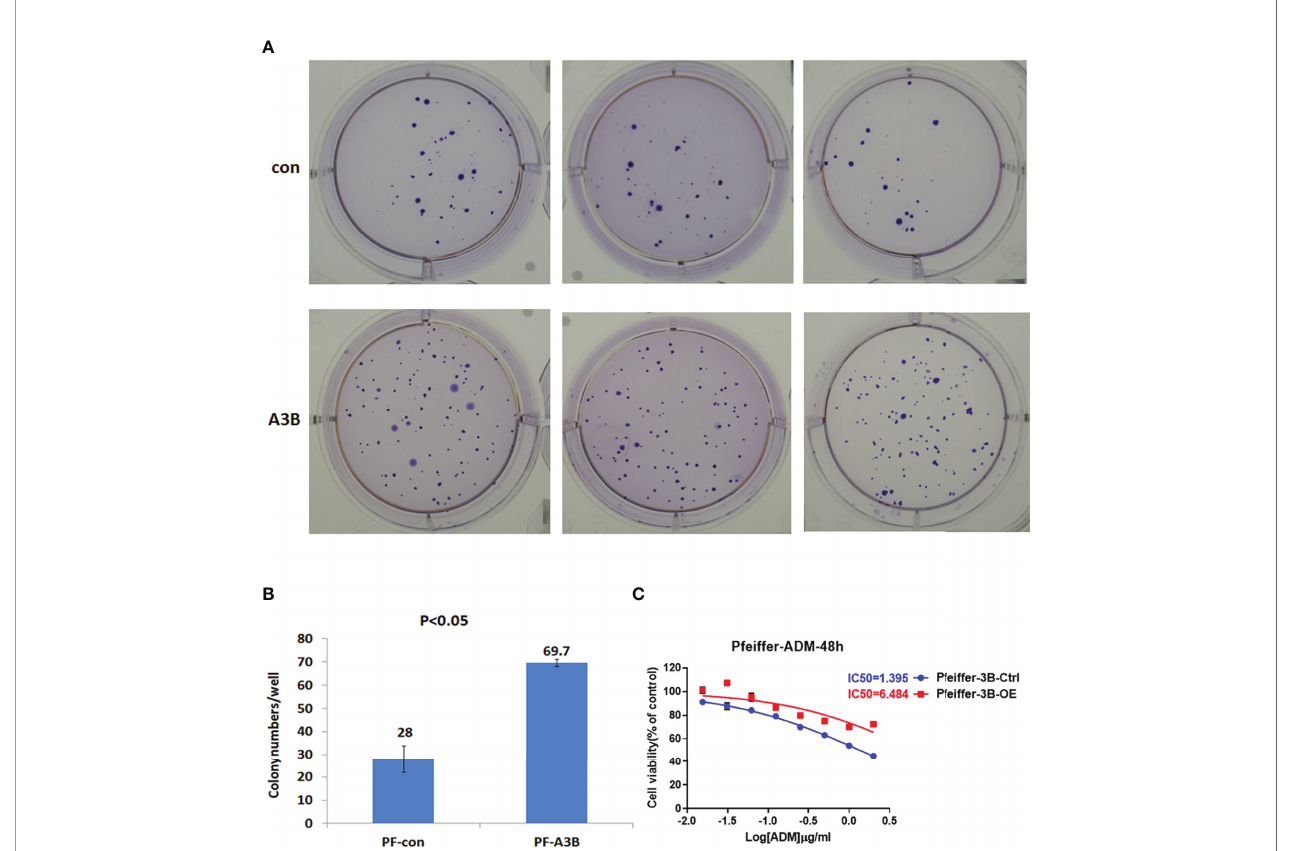
FIGURE 7 | APOBEC3B-induced proliferation and drug resistance in DLBCL cells. (A, B) Colony formation after induction of APOBEC3B expression. A3B inducible, APOBEC3B-Flag/pLV-Ptight-puro vector-transfected Pfeiffer cells; Con, pLV-Ptight-puro vector-transfected Pfeiffer cells; PF-A3B, APOBEC3B-Flag/pLV-Ptight-puro vector-transfected Pfeiffer cells; PF-con, pLV-Ptight-puro vector-transfected Pfeiffer cells. (C) Doxorubicin resistance after induction of APOBEC3B expression. ADM, doxorubicin; Pfeiffer-3B-Ctrl, pLV-Ptight-puro vector-transfected Pfeiffer cells; Pfeiffer-3B-OE, APOBEC3B-Flag/pLV-Ptight-puro vector-transfected Pfeiffer